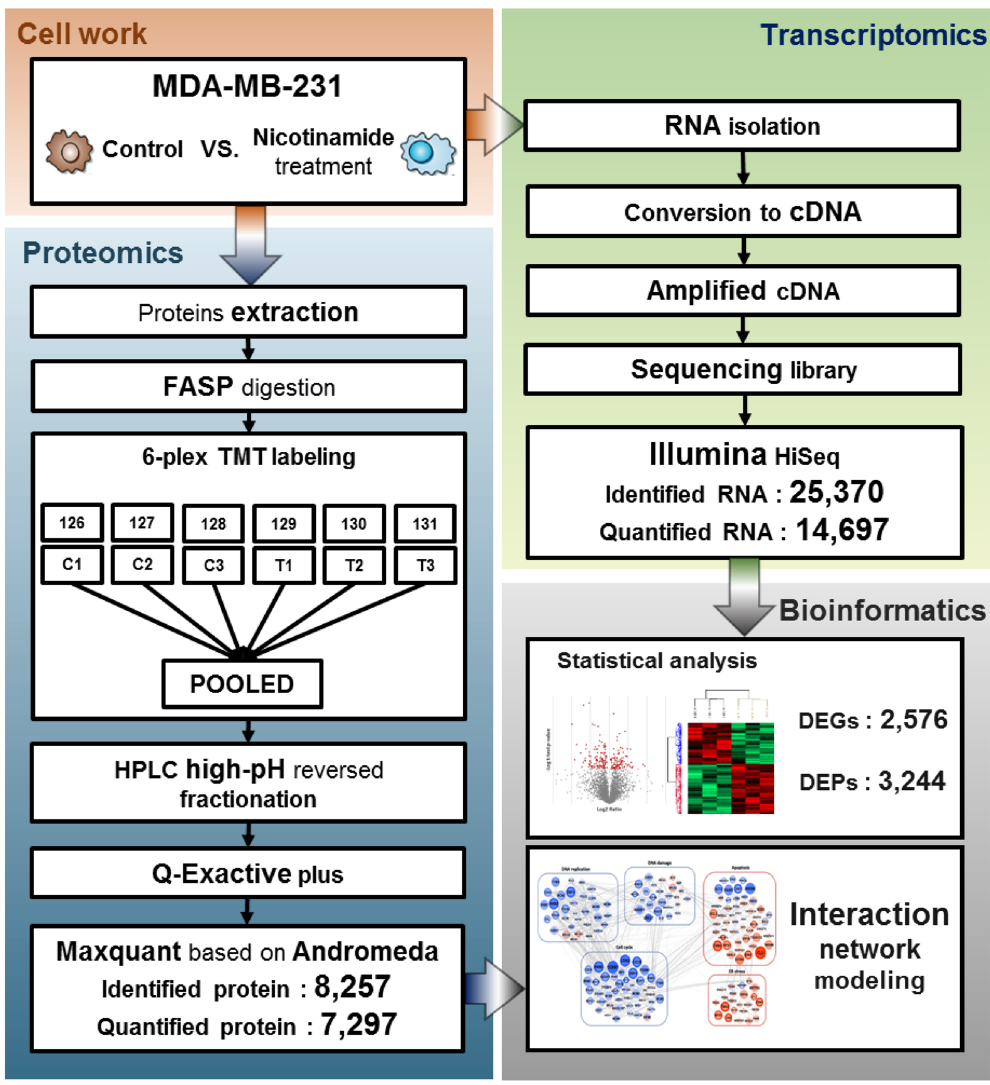
Figure 2. Schematic representation of the experiment workflow to analyze the changes in the transcriptome and proteome of MDA-MB-231 cells in response to